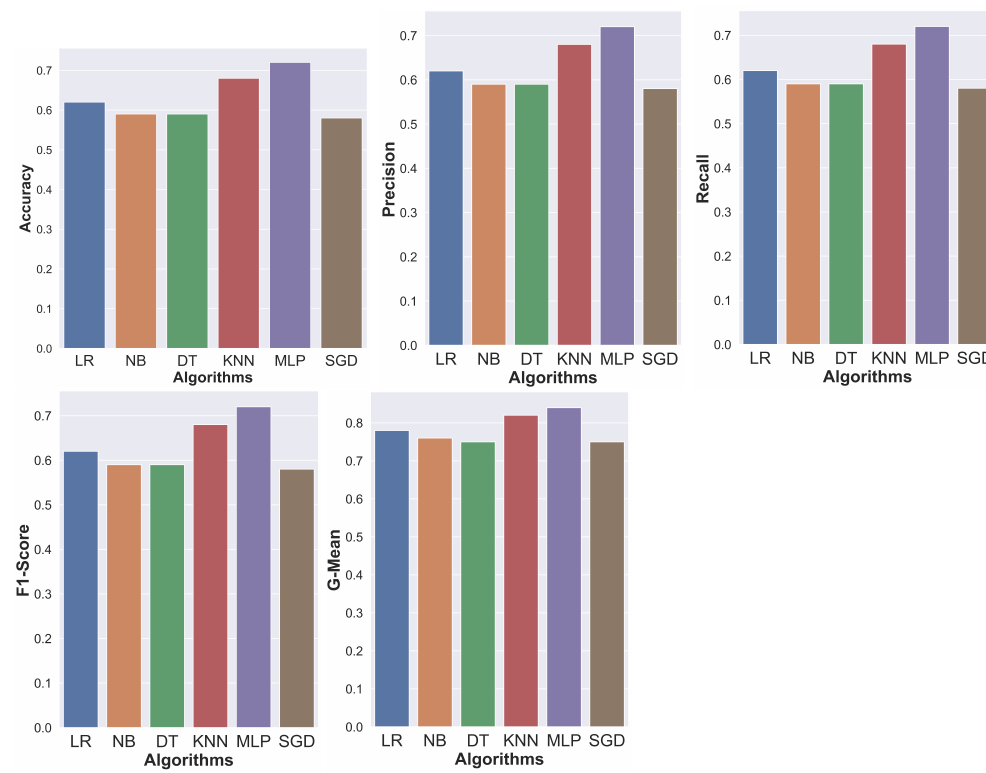
Figure 8. Score values of the various measures for BDD100K. Table 4. Score values of the various measures for groups in the BDD100K